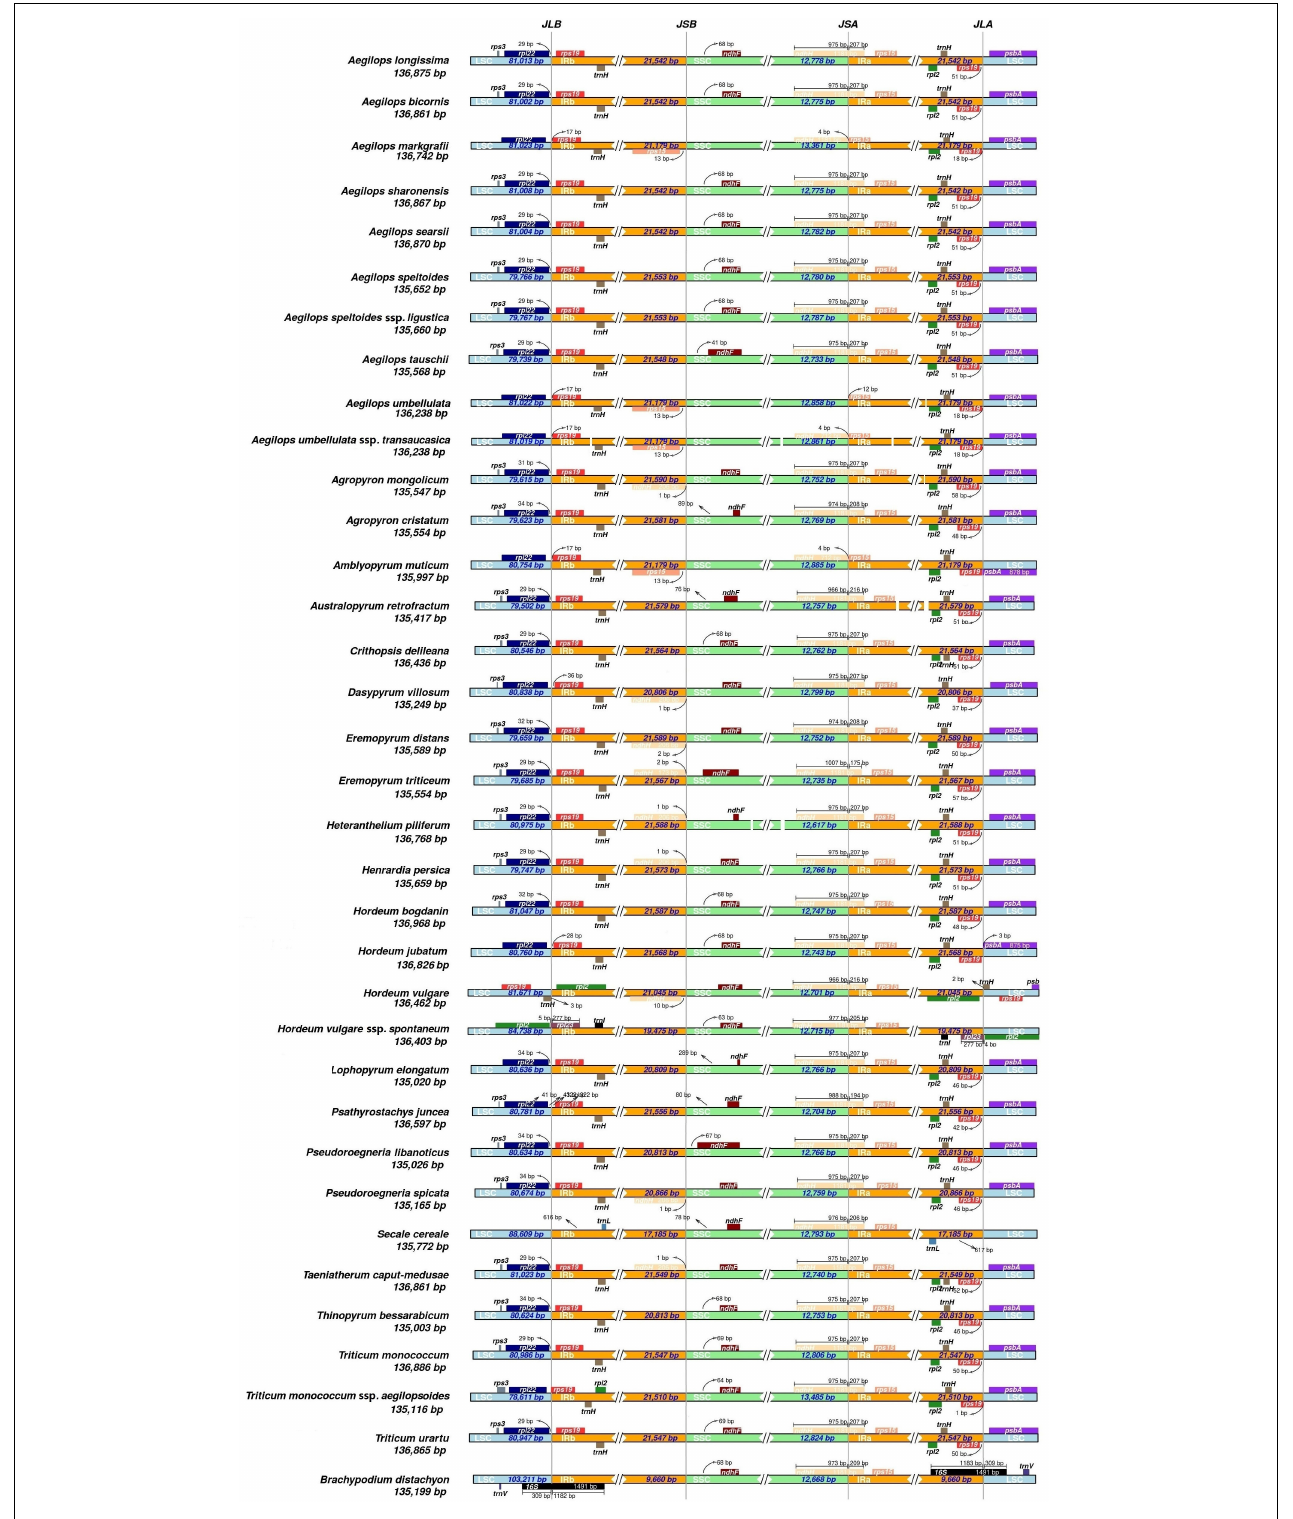
FIGURE 2 | Comparison of the borders of the large-single-copy (LSC) (blue), small single copy (SSC) (green), and inverted repeat (IR) (orange) regions among the 34 cp genomes.